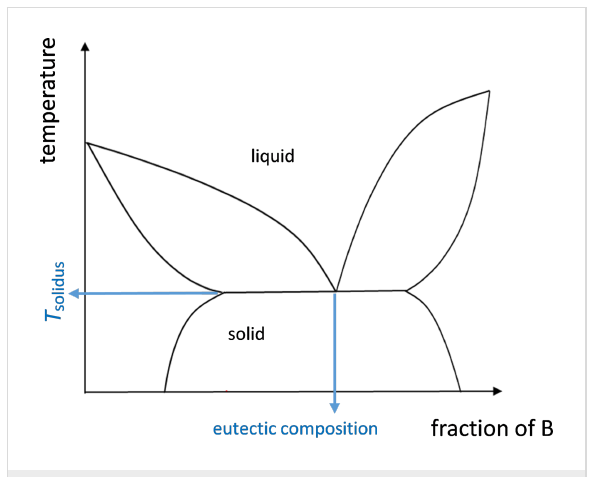
Figure 8: Scheme of phase diagram with eutectic mixture.